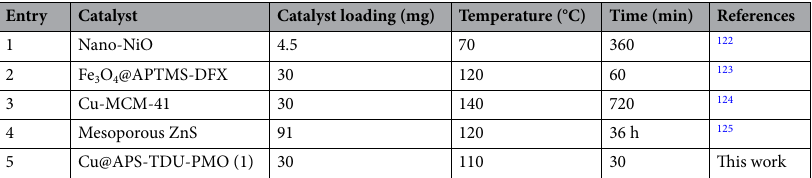
Table 4. Comparison of the catalytic activity of Cu@APS-TDU-PMO ( 1 ) with other reported catalytic systems.